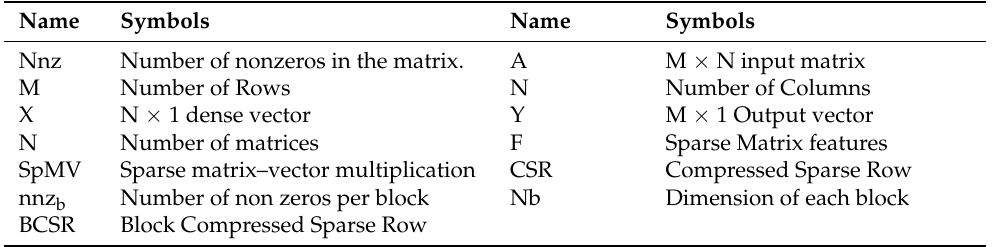
Table 1. Symbol used in the paper.